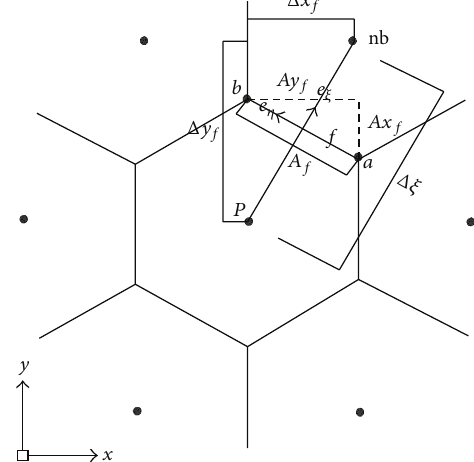
Figure 1: The 2D schematic Voronoi mesh cell used for describing the discretization of the governing